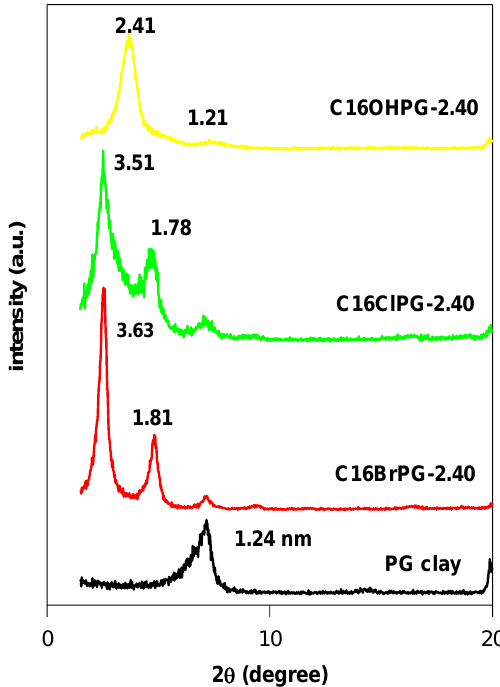
Figure 3. Powder XRD patterns of PG clay and its OCs prepared from different C16TMAX solutions.